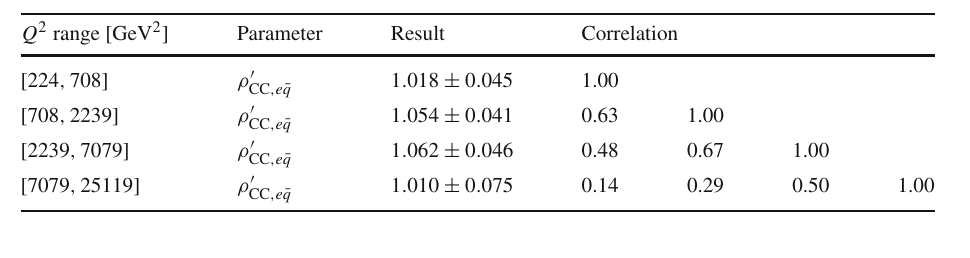
Table 18 Results for the ρ (cid:6) parameters determined at different values of Q 2 . The Q 2 range of the data selection, and the correlation coefficients of the fit parameters are